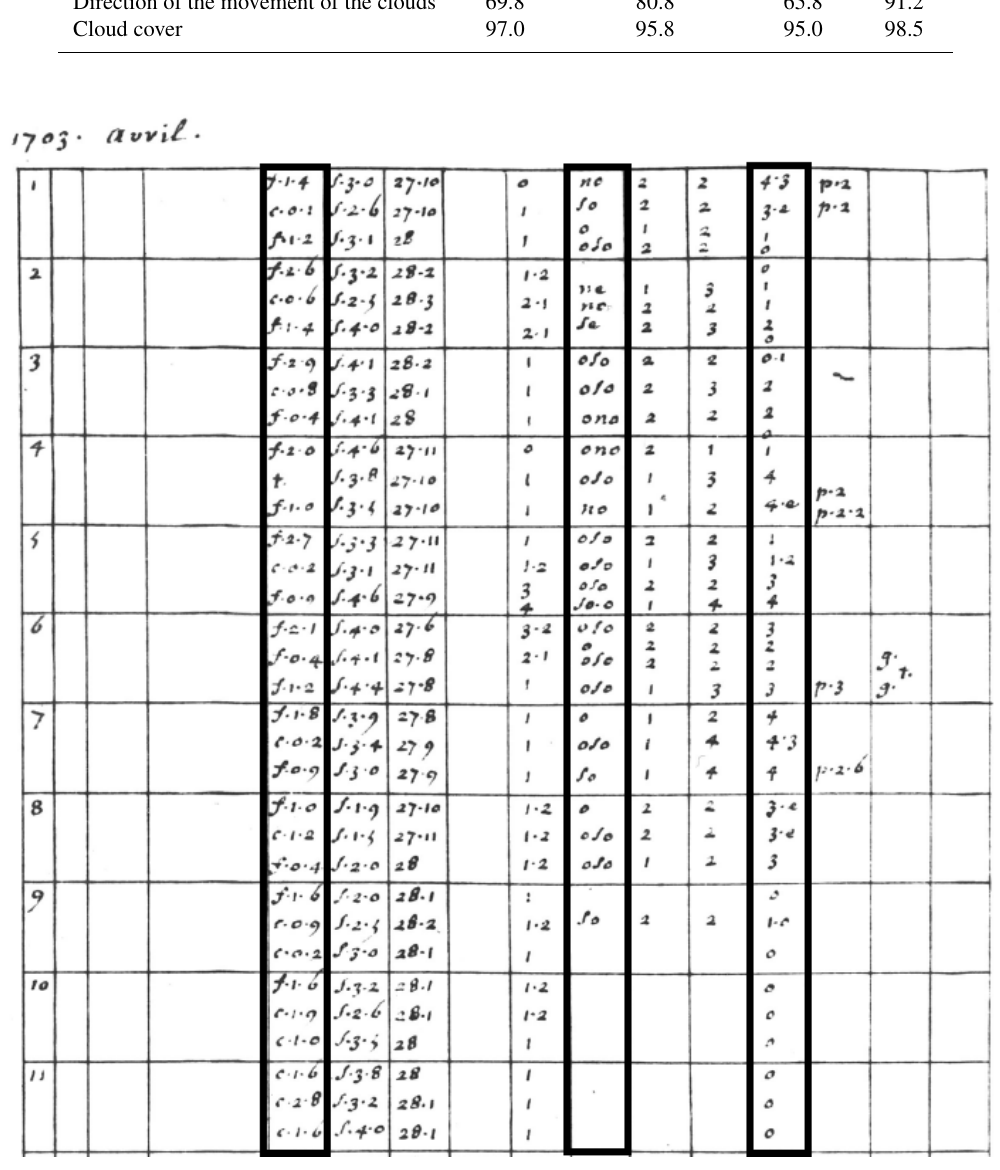
Figure 1. Example of Morin’s notes (source: Institute of History/Oeschger Centre for Climate Change Research, University of Bern). Column 1 shows the day of the month; column 2 shows the day of the lunar cycle; column 3 shows the conjunction, opposition, and other aspects of the moon and the sun; column 4 shows the conjunction, opposition, and other aspects of the planets; column 5 shows the thermometer measurements; column 6 shows the hygrometer measurements; column 7 shows the barometer measurements; column 8 shows the wind direction; column 9 shows the wind strength; column 10 shows the direction of the movement of the clouds; column 11 shows the regional origin of air; column 12 shows the speed of the clouds; column 13 shows the cloud cover; column 14 shows intensity and duration of rainfall; column 15 shows fog, snow, small hailstones, thunder perihelion, and the color of the sky; column 16 gives miscellaneous observations, such as earthquakes, comets, and halos. For more details, see the